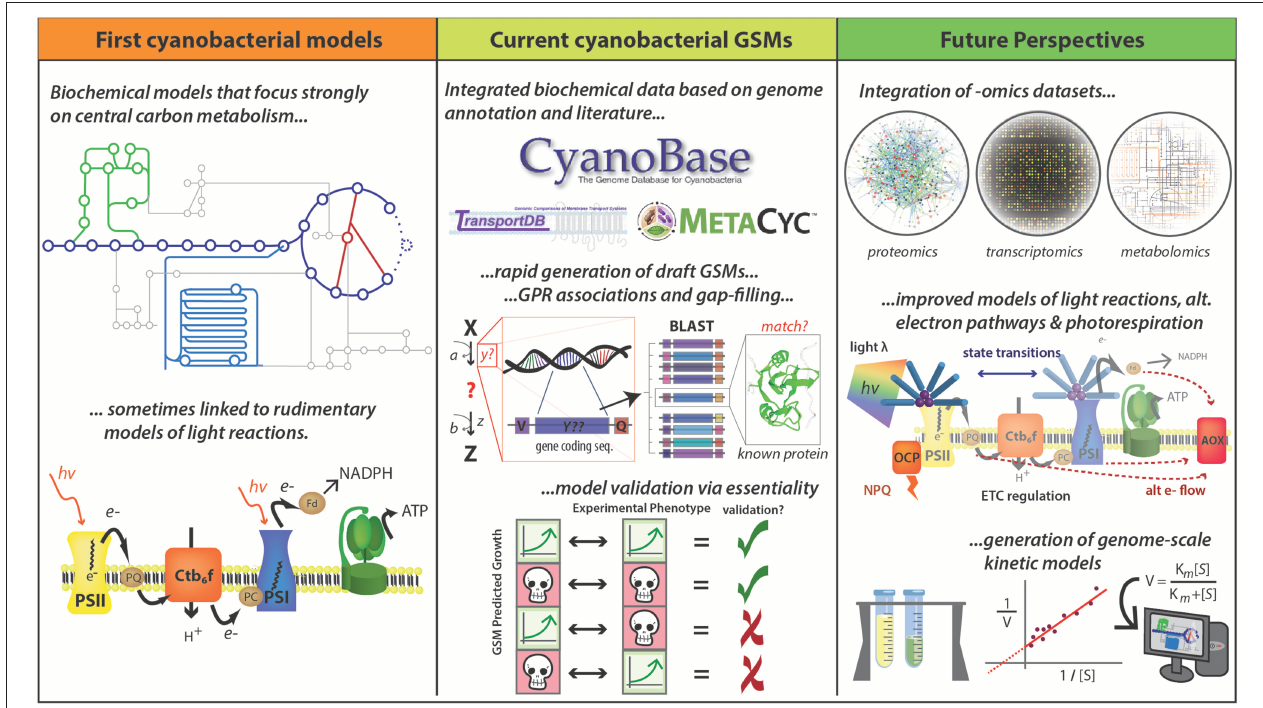
FIGURE 4 | Development of cyanobacterial GSMs. Early cyanobacterial GSMs were developed based on biochemical data and were focused mainly on central carbon metabolism and linked to basic representations of photosynthetic pathways ( Cogne et al., 2003; Shastri and Morgan, 2005; Hong and Lee, 2007). Numerous advances have accelerated the reconstruction of GSMs, including improved quantity and quality of data described in public databases (e.g., CyanoBase, TransportDB, KEGG, and MetaCyc) and the development of tools for rapid generation of drafts and for gap-filling. The quality of GSMs has been substantially improved with the inclusion of gene-protein-reaction (GPR) associations, which has been assessed by essential gene prediction based on the availability of experimental data. This methodology allows identify four different kind of predictions: true positives, true negatives, false positives, and false negatives. True positives and true negatives are obtained when both prediction and experimental data indicate a gene is essential and non-essential, respectively (the first and the second case). False positives occur when the model says a gene is essential, but experiments suggest otherwise (the third case). False negatives are generated when a gene is predicted to be non-essential but in reality, it is essential (the fourth case). However, new improvements could further improve GSM predictive ability, including the integration of—omics datasets and the improvement of photosynthesis and photorespiration modeling. A long-term goal would be the development of genome-scale kinetic models, which might be expected to provide more accurate metabolic predictions. Logos for MetaCyc, TransportDB, and CyanoBase are used with